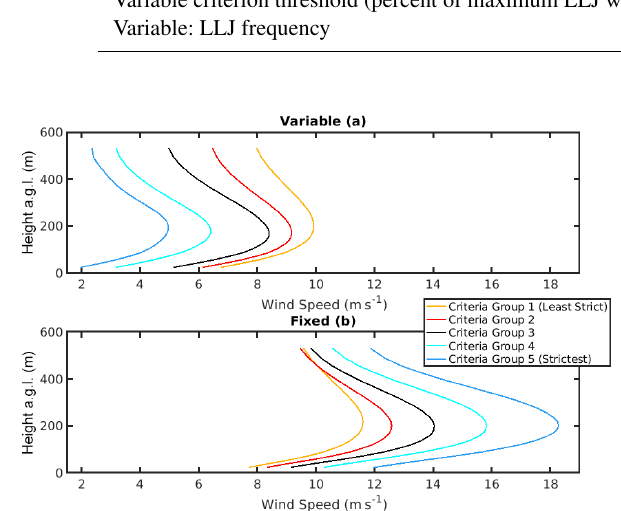
Table 4. Marginal probabilities of LLJs when each of the variable selection criteria are applied. Results are shown for hourly wind speed profiles from the single grid cell of highest LLJ frequency according to the seasonal study previously developed. Criteria group